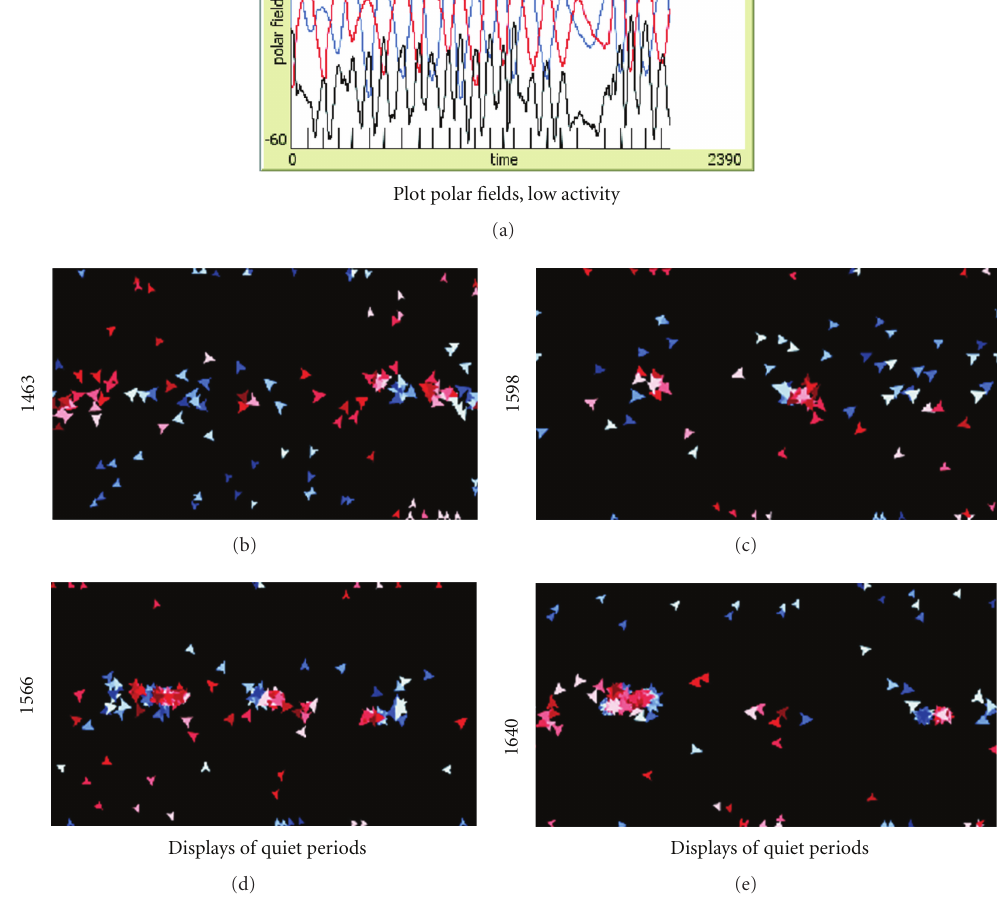
Figure 5: Top panel shows Plot A for 2000 ticks, and lower panels display maps during quiet intervals, as shown. During later phases (see Plot A at the top), long periods of low activity, activity are reminiscent of “Maunder Minimum” conditions occur. The Plot A type is again of the Sun’s polar fields as in the earlier graphs, so that the blue curve displays the amount and sign of the magnetic flux in the northern magnetic pole, namely the mean field above 60 degrees latitude. The red curve, similarly counts the mean field in the Southern polar region. As with the Sun, the two polar fields anti-correlate with each other. The black curve again displays the amount of magnetic flux in the polar regions; it is thus a rough estimate of the amount of solar activity. Following such periods, the field recovers for every model run we have undertaken. One sees detailed circumpolar rivers of blue and red field line magnetic entities circumnavigating the solar poles during these intervals. The top curves in this figure show a plot similar to Plot A, with the three colored curves: blue, red, and black. The blue curve displays the amount and sign of the magnetic flux in the northern magnetic pole, namely, the mean field above 60 degrees latitude. The red curve similarly counts the mean field in the Southern polar region. The black curve marks the Absolute Value Sum of the red and blue curves. So, this curve in black displays the amount of magnetic flux in the polar regions. It has been artificially placed 60 units downwards, for increased clarity. It essentially reaches a peak, during a solar cycle